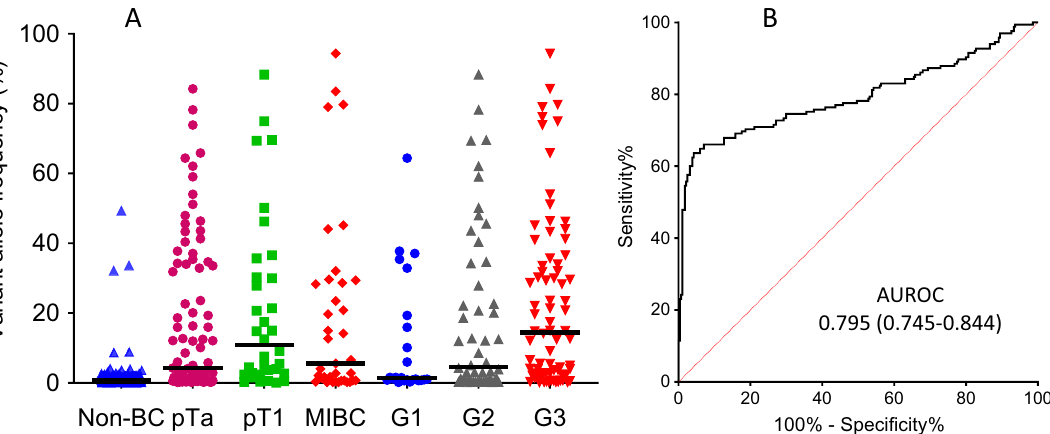
Figure 2. Hotspot mutations in urine cpDNAs from incident BC patients. ( A ) Shows the highest VAFs in cpDNAs from the testing set non-BCs (n = 284) and 165 BCs by stage and grade. ( B ) Shows the ROC curve for incident BC detection obtained by varying the VAF used for variant calling.